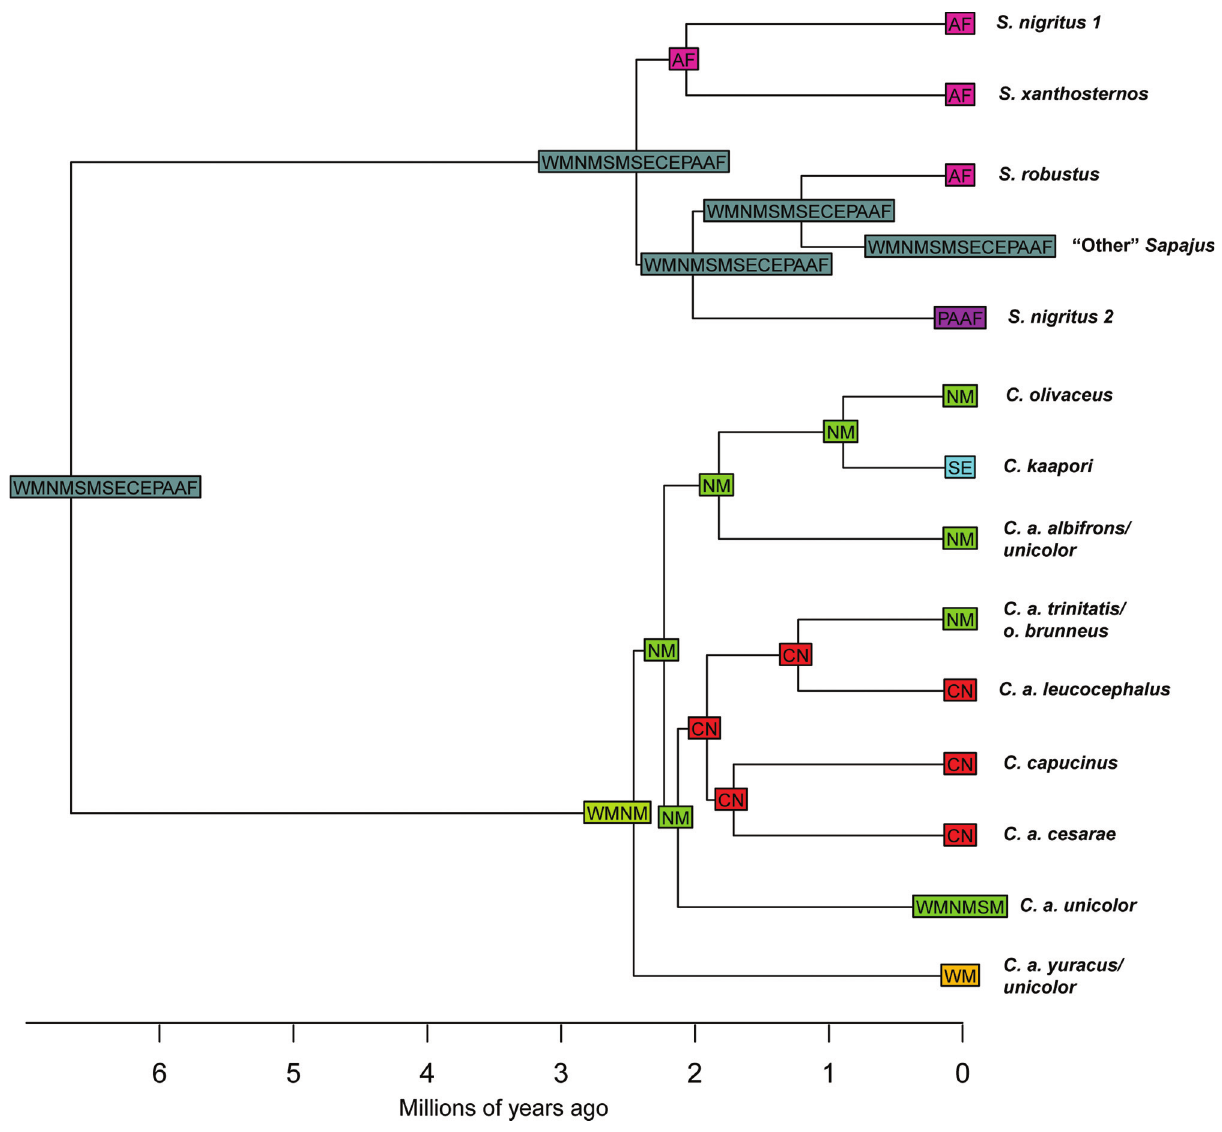
Figure 5 - DS2 time consensus tree with the estimates of ancestral areas of the capuchin monkeys made in `BioGeoBEARS’ through the DEC-J model. CN = Central America + North Andes; WM = West Amazon; NM = North Amazon + Coastal Venezuela; SM = South Amazon; SE = Southeast Amazon; CE = Cerrado; PA = Paraguay/Argentina; AF = South and North Atlantic